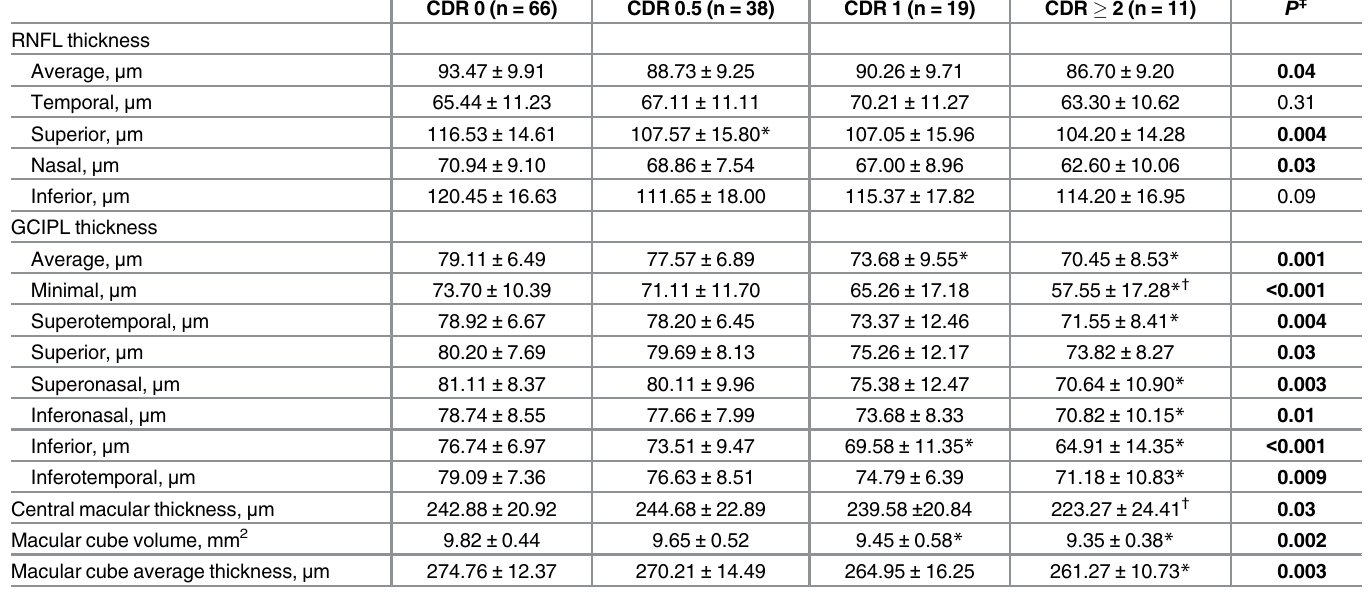
Table 2. Retinal nerve fiber layer (RNFL) and ganglion cell inner plexiform layer (GCIPL) thicknesses according to the clinical dementia rating scale